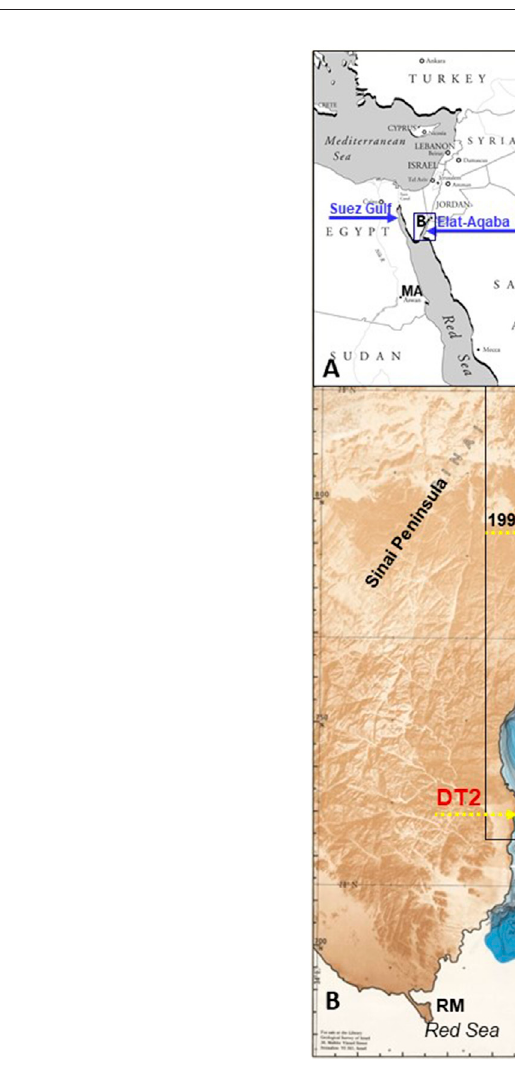
Frontiers in Earth Science |